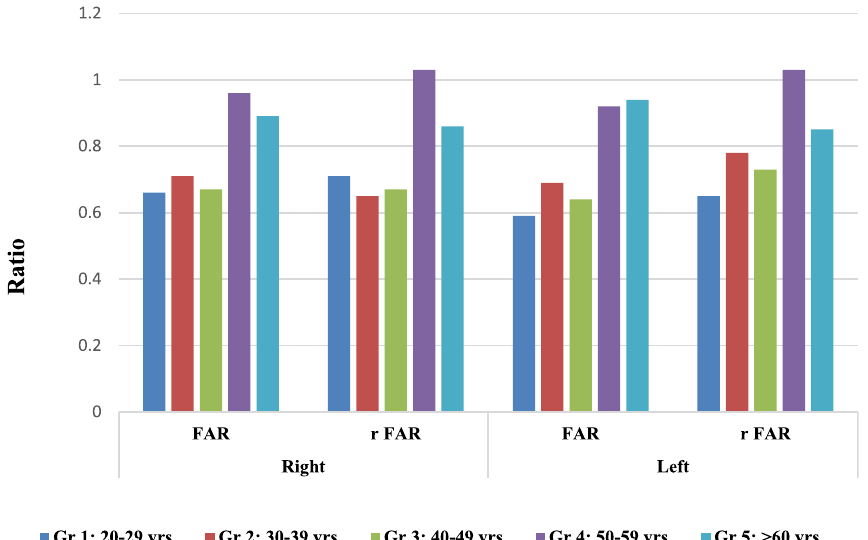
Fig. 4 cVEMP air conduction FAR and r FAR of the right and left ears of the 5 age groups in this study. There were no statistically significant differences between the right and left ears cVEMP air conduction FAR or rectified FAR of the any of the 5 age groups in this study ( p >